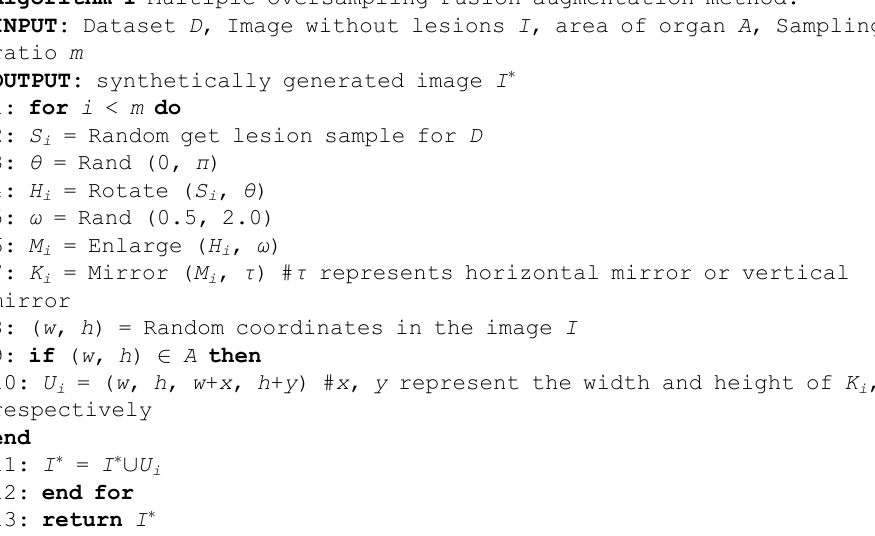
Algorithm 1. Algorithm 1 Multiple Oversampling Fusion augmentation